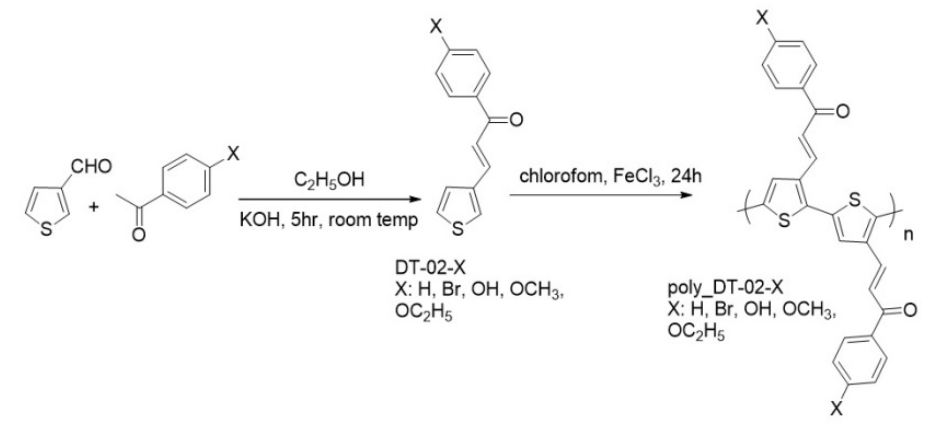
Figure 1. System energy ( a ), electronic density ( b ), electronic state ( c ) of poly(C 13 H 8 OS–H) with a different number of steps.